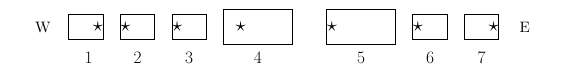
Figure 6. Geometry of the model for the 2012 Emilia seismic se- quence. The rectangles are the projections of faults on a vertical plane. Faults are numbered from west to east. Stars indicate the hypocentres.